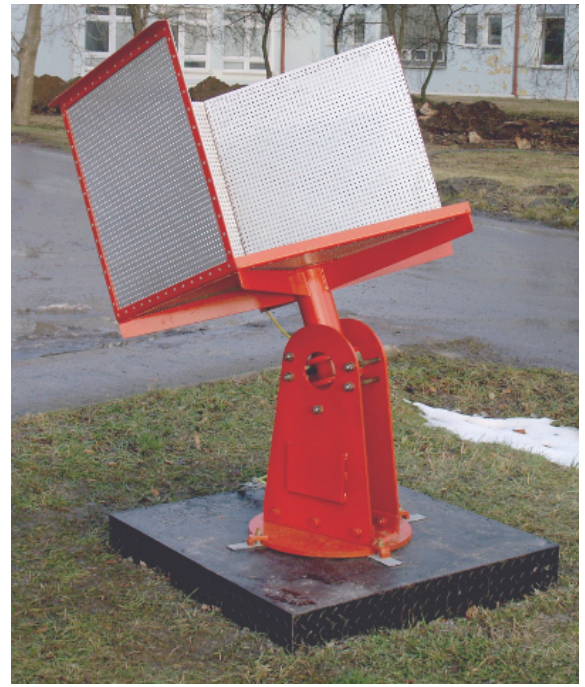
Figure 3: A photo of a